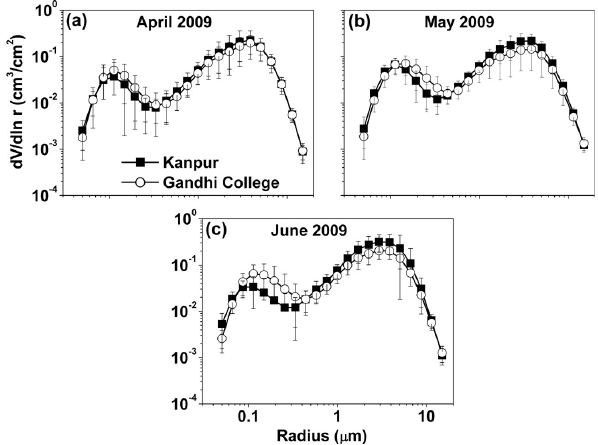
Fig. 4. Aerosol volume size distribution for 22 size bins be- tween 0.05 and 15µm at Kanpur and Gandhi College during (a) April 2009, (b) May 2009 and (c) June 2009. The vertical bars at each size bin indicate standard deviation (SD) from their